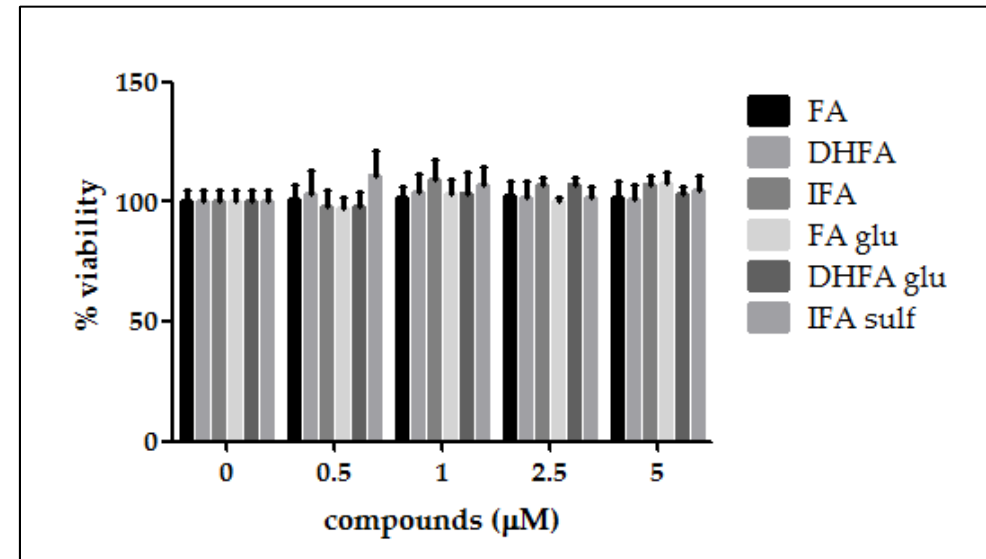
Figure 1. Percentage of cell viability compared with the control (0 μ M, 100% viable cells) of Caco ‐ 2 cells incubated for 48 h with different concentrations of ferulic acid (FA), dihydroferulic acid (DHFA), isoferulic acid (IFA), ferulic acid glucuronide (FA glu), dihydroferulic acid glucuronide (DHFA glu), and isoferulic acid sulfate (IFA sulf; 0.5–5 μ M). Each column represents the mean ± SD of the independent experiments ( n = 12).